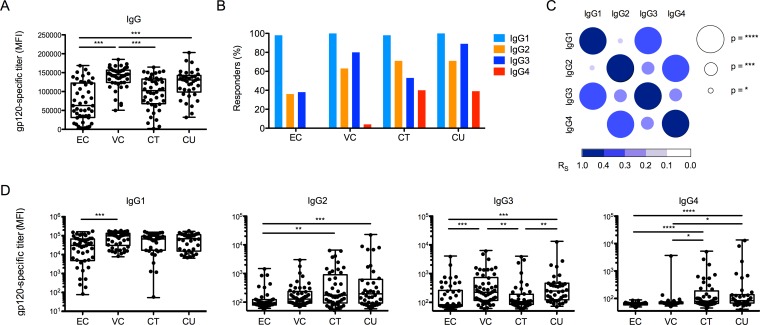
Levels and IgG subclass composition differentiate HIV+ subject groups.
A. Titer (Mean Fluorescent Intensity, MFI) of gp120-specific IgG present in each subject group. B. The percent of subjects in each group positive for gp120-specific responses of each IgG subclass. C. Spearman correlation matrix between subclass responses across subjects. Strength and significance, as calculated in Graphpad Prism, are represented as color intensity and size, respectively. D. The levels of gp120-specific responses observed across cohort groups for each IgG subclass. Differences between groups were assessed by Kruskal-Wallis ANOVA and corrected for multiple comparisons using Dunn’s test in Graphpad Prism.